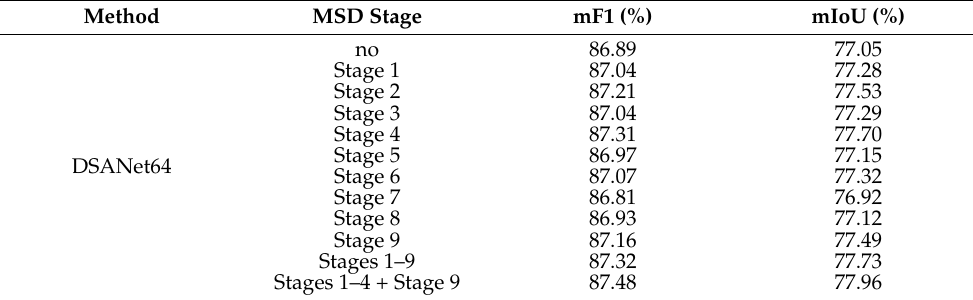
Table 6. Comparison of MSD Losses Achieved on the Potsdam Data Set in Different Stages.